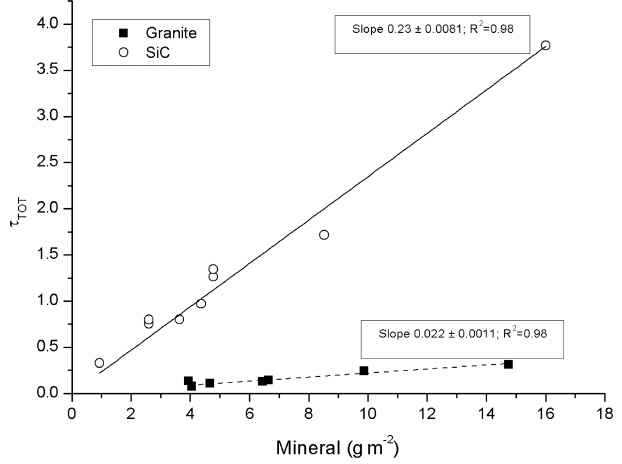
Figure 4. The optical depth (at λ = 526nm) as a function of the amount of minerals present on the filter.